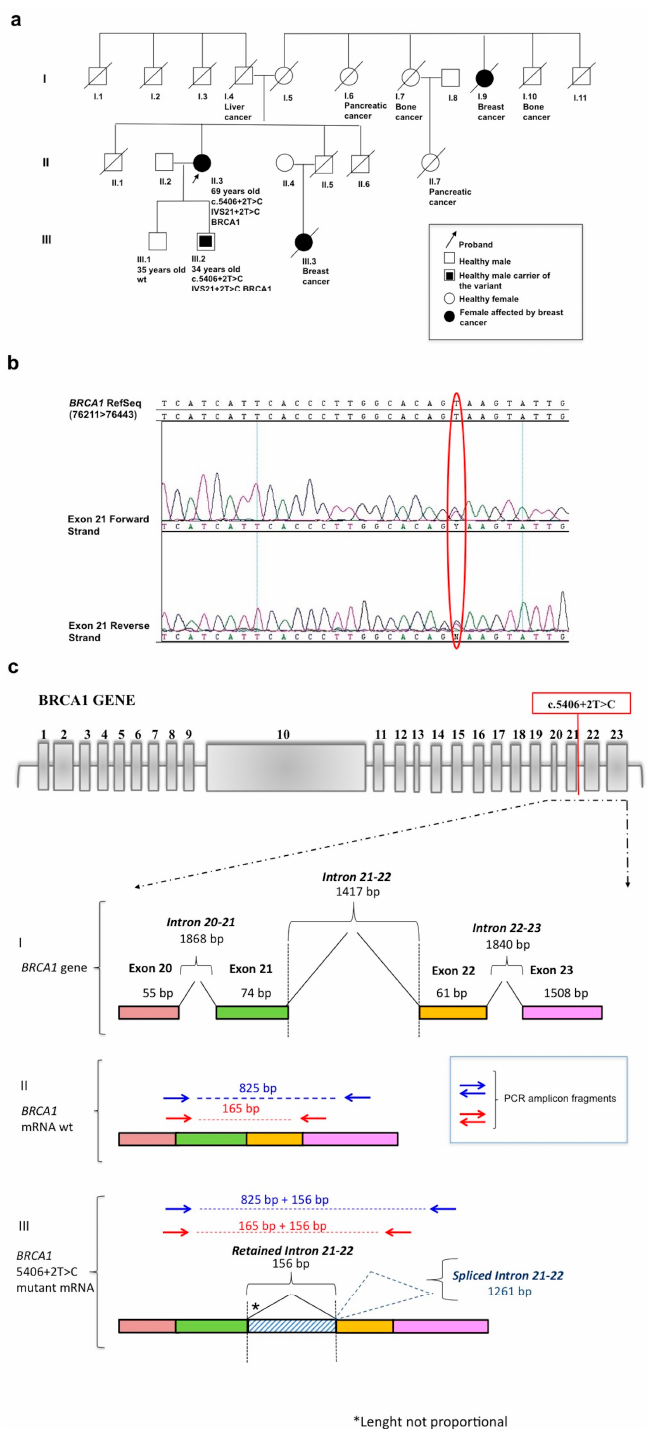
Figure 1. ( a ) The pedigree of the patient’s family, and the type of cancer in her deceased relatives; ( b ) The patient’s electropherogram. Exon 21 of the BRCA1 gene (after next-generation sequencing) was analyzed by standard Sanger sequencing, which confirmed the presence of the c.5406+2T>C splice variant (encircled in red); ( c ) Schematic view of the effects of the variant. The schematic representation of the BRCA1 gene exon-intron structure and the variant localization is reported in the top panel. Below is the scheme of the exon-intron sequence spanning from exon 20 to 23. The colored bars represent exons 20–23 of the BRCA1 gene, at both the genomic (I) and cDNA level (II and III). The mutated cDNA carrying the retained 156 bp of intron 21 is shown (III). Arrows indicate the PCR amplicon fragments derived from the custom-designed primer pairs (see Materials and Methods).